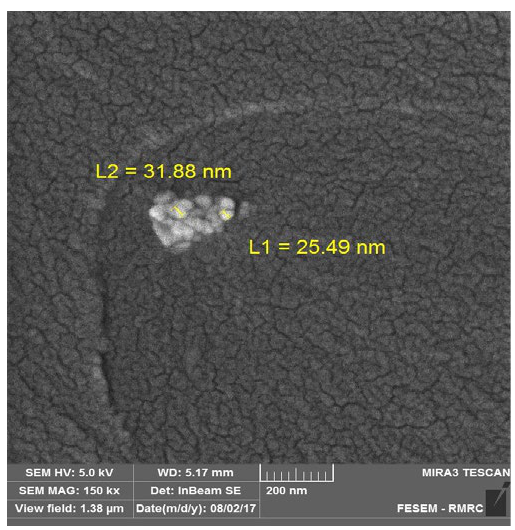
Fig. 2. Size of ZnO in chitosan film